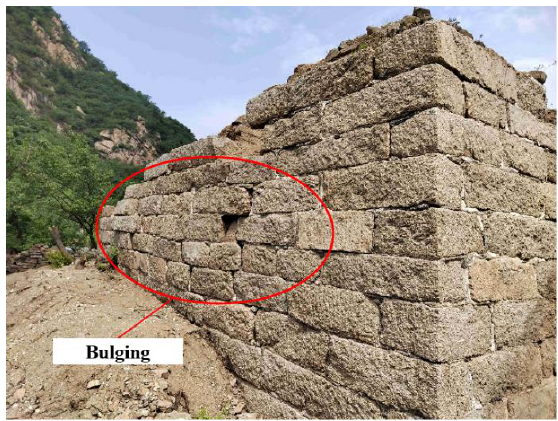
Figure 9. Bulging base wall.